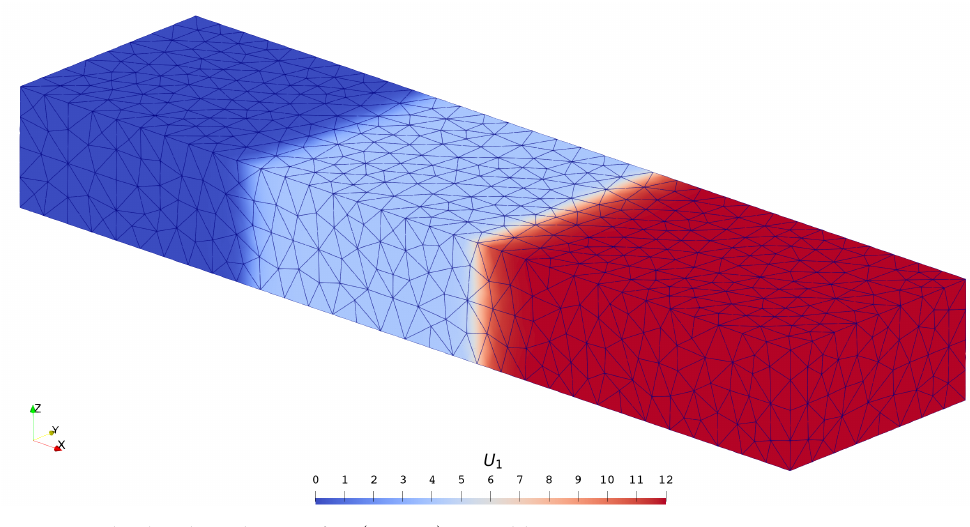
Figure 7. Third-order solution of U 1 ( t = 0.3 ) in Problem 2.